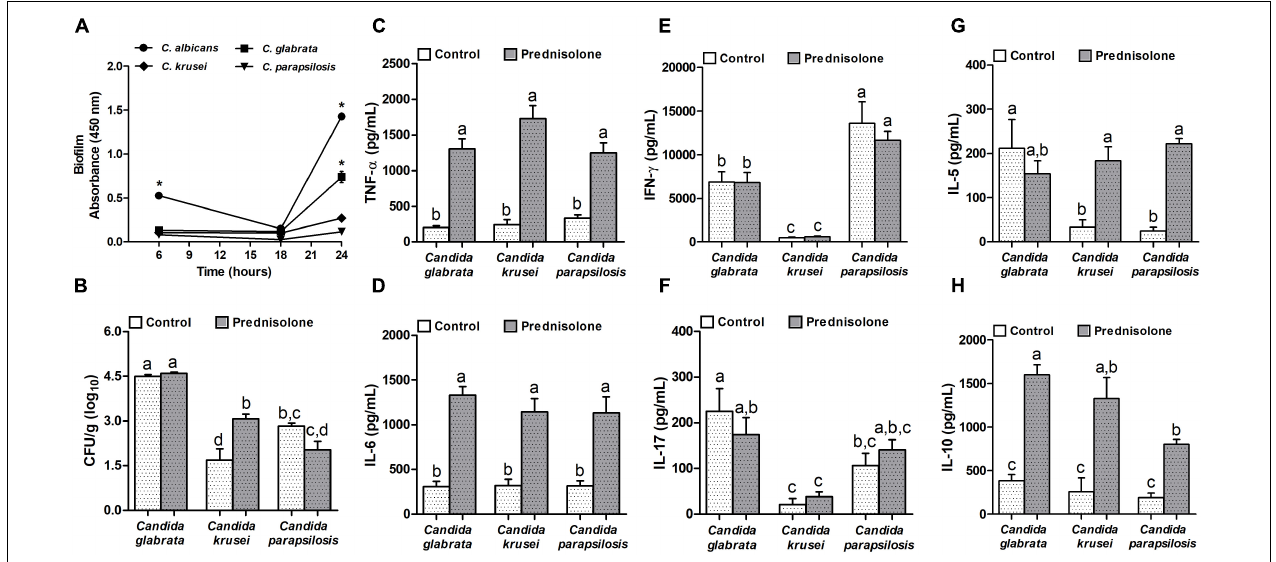
FIGURE 3 | Non- albicans Candida species: biofilm formation and effect of prednisolone on fungal load and cytokine production in spleen. Absorbance of in vitro biofilm assay (A) , spleen fungal load (B) , and production of TNF- α (C) , IL-6 (D) , IFN- γ (E) , IL-17 (F) , IL-5 (G) and IL-10 (H) by spleen cell cultures of immunocompetent (Control) and immunosuppressed (Prednisolone) infected-mice. The results are expressed as mean ± SEM; ∗ and different letters indicate statistical difference among groups analyzed by One-way ANOVA with post hoc Tukey test; p < 0.05; n = 8/group or n = 3/group in biofilm assay.